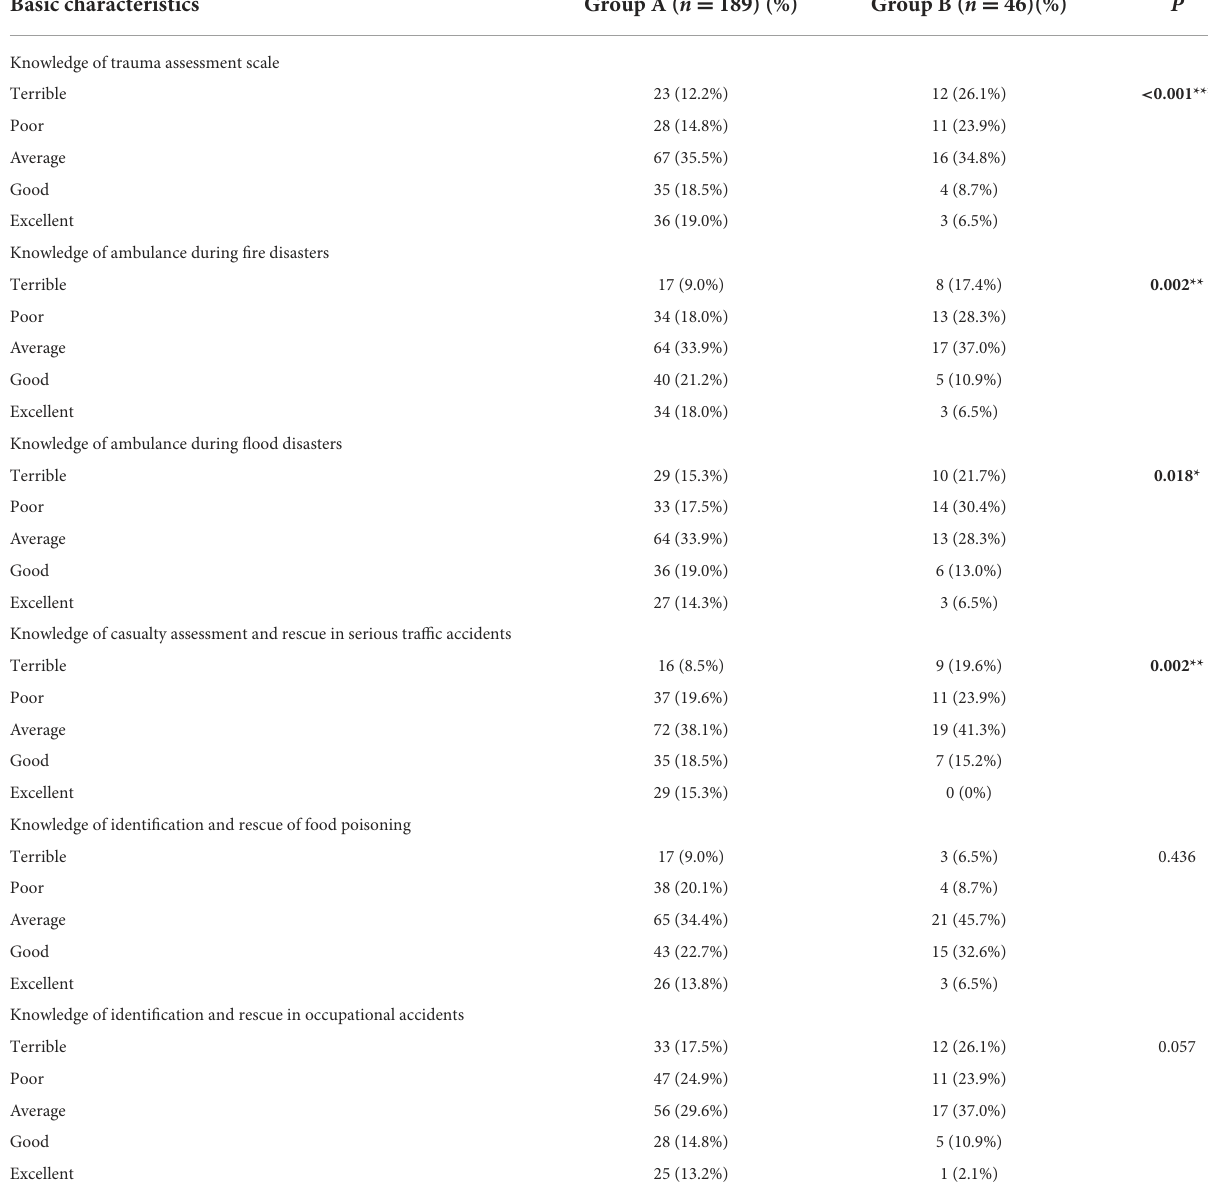
TABLE 3 Comparison of the knowledge of noncommunicable diseases associated with public health emergencies between clinical and preventive medical students. Basic